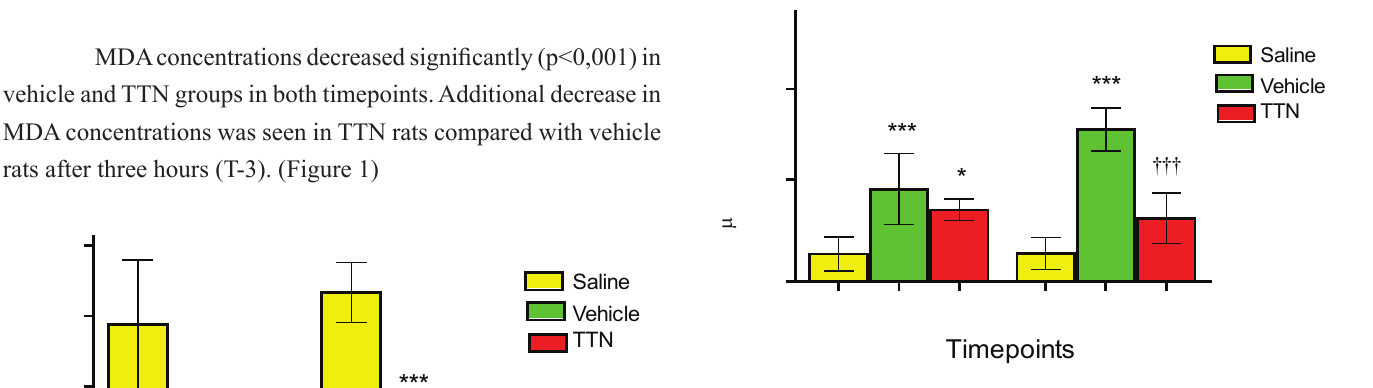
FIGURE 2 - Reduced glutathione (GSH) concentrations (micromoles of GSH per gram of fresh tissue) in testis homogenates of saline, DMSO and ternatin (TTN) pretreated rats. Bars represent mean ± SD of control (yellow bars), vehicle (green bars) and TTN (red bars) groups at the end of the ischemia (T-0) and during reperfusion (T-3), Vehicle (*** P< 0.001) and ternatin groups (P<0.05) are significantly different from control group by ANOVA test. ††† P< 0.001 compared with vehicle group.